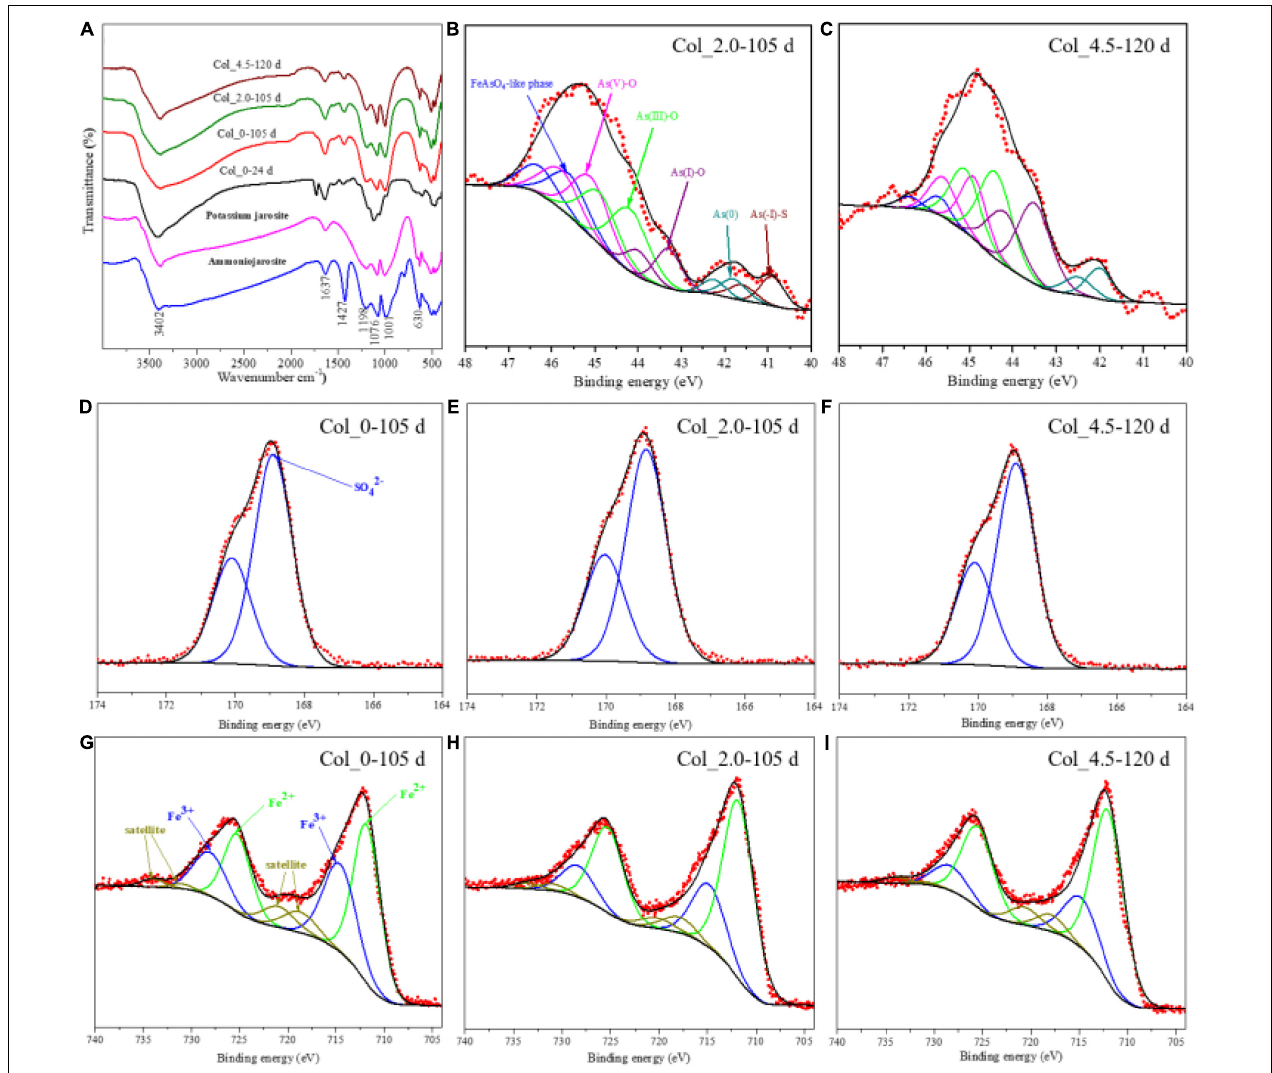
FIGURE 3 | FT-IR spectra (A) and XPS spectra of the surface As (B,C) , S (D–F) , and Fe (G–I) for the surface suspended matter at 24/105, 105, and 120 days of the water columns without (Col_0) and with additions of 2.0 mM (Col_2.0) and 4.5 mM (Col_4.5) As(III),